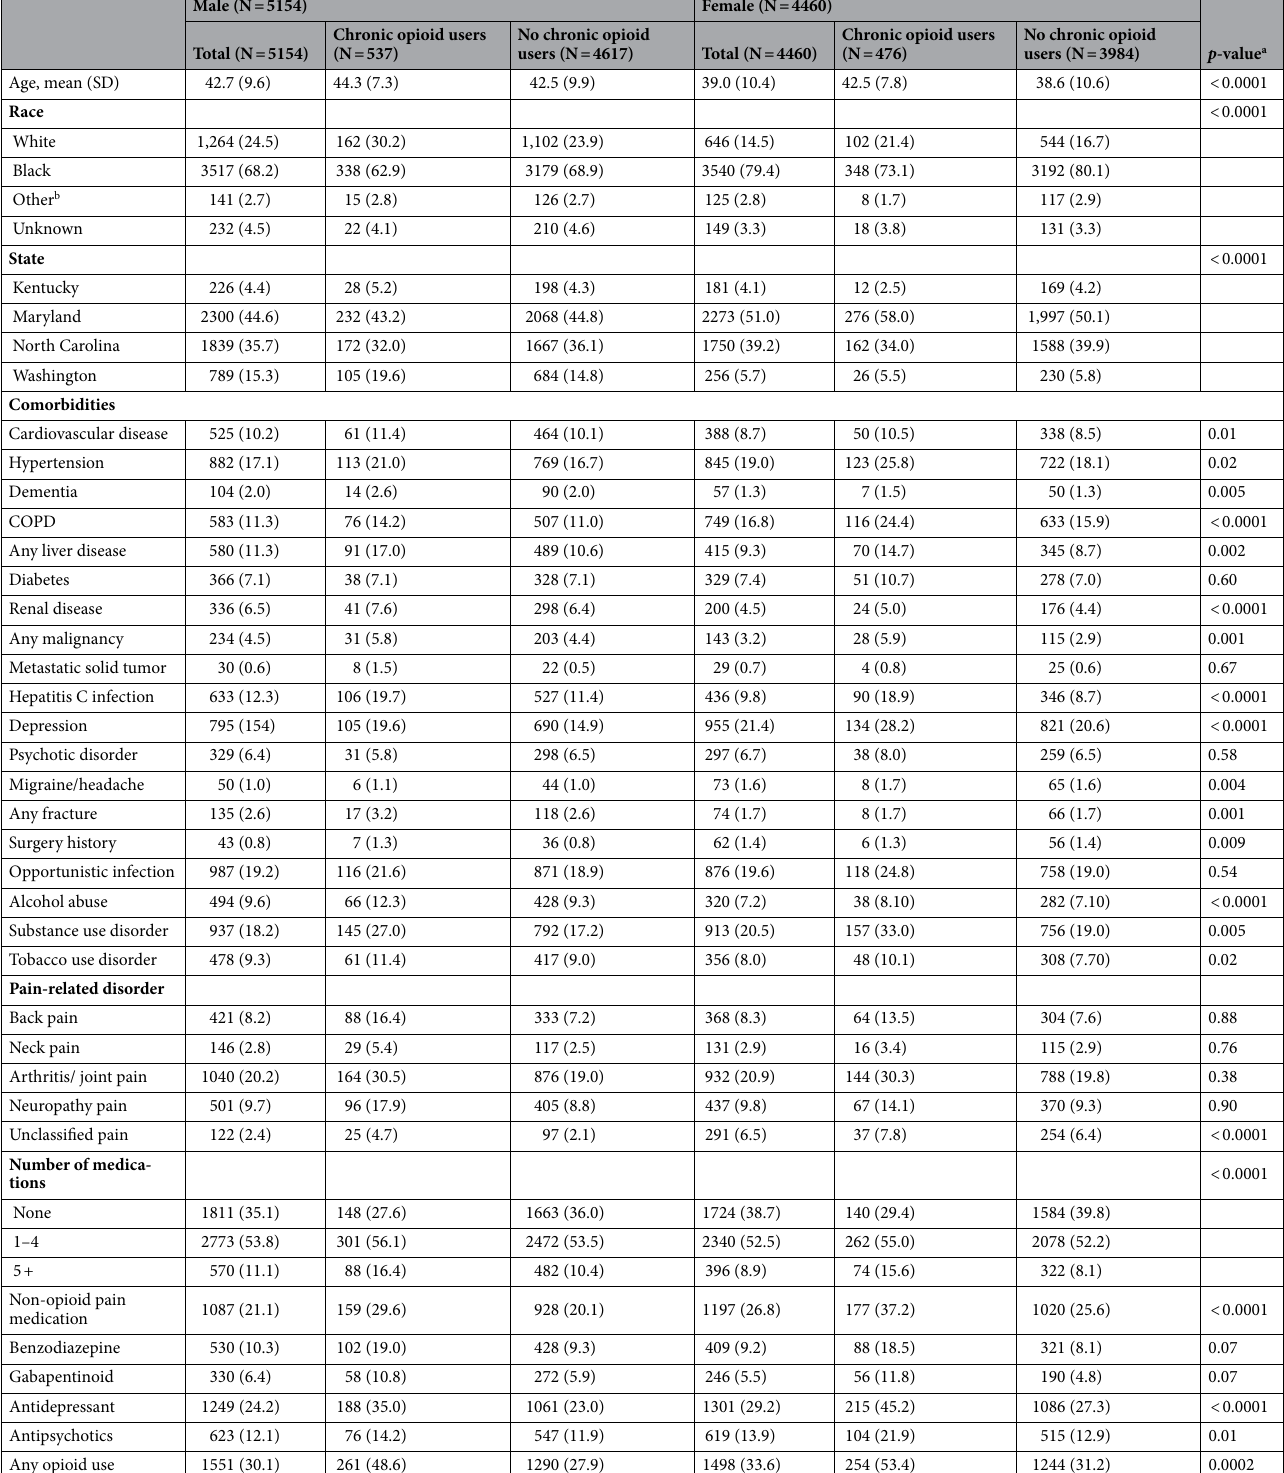
Table 3. Characteristics of study sample by sex. All results presented are N (%) unless otherwise noted. Abbreviation COPD, Chronic pulmonary disease. a T-test and Pearson Chi-Square tests were used to assess differences between male and female beneficiaries. b American Indian, Alaskan Native, Hispanic, Asian, Pacific Islander, Native Hawaiian, more than one